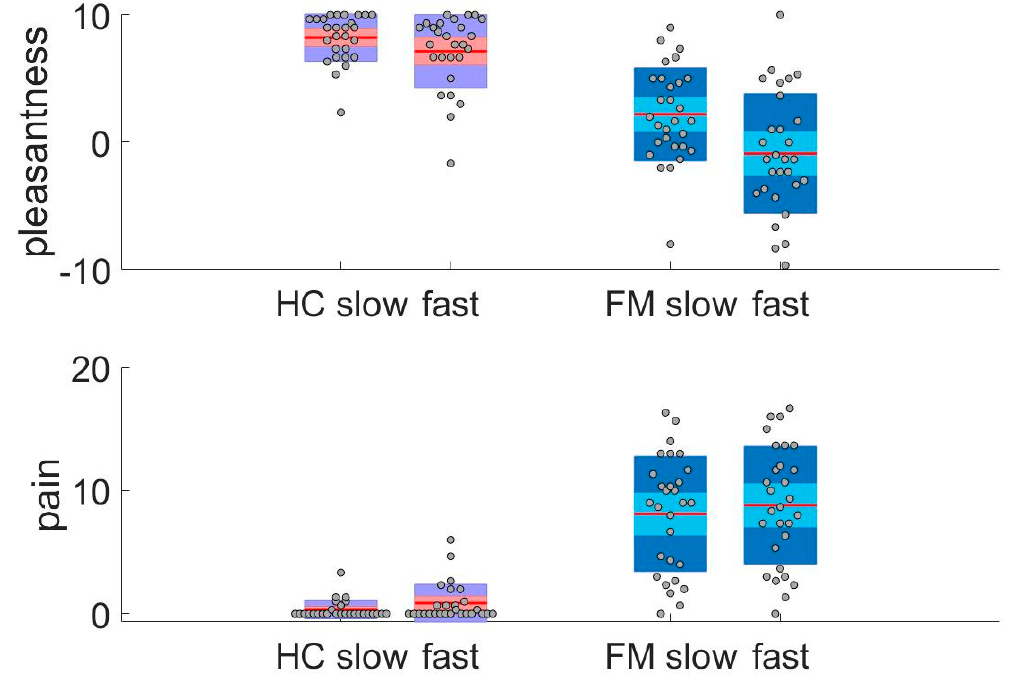
Figure 1. Ratings of touch pleasantness and pain during fMRI. Top: HC rated slow and fast brushing as similarly pleasant on a VAS (mean slow = 8.2 ± 1.9, mean fast = 7.2 ± 3, Z = –1.6, p < 0.103). FM rated slow brushing as significantly more pleasant than fast (mean slow = 2.1 ± 3.7, mean fast = –0.9 ± 4.7, t = 4.9, p < 0.001). Groups di ff ered in their ratings of the di ff erent conditions (Mann–Whitney U test, pleasantness ratings: slow Z = –5.7, p < 0.001, fast Z = –5.4, p < 0.001). Bottom: HC rated less pain after slow than after fast brushing on a VAS (mean slow = 0.33 ± 0.04, mean fast = 0.86 ± 1.53, Z = –2.4, p < 0.017). FM rated less pain after slow than after fast brushing (mean slow = 8.3 ± 4.7, mean fast = 9 ± 4.9, t = –2.7, p < 0.011). The groups di ff ered in their ratings of the di ff erent conditions (Mann–Whitney U test, pain ratings: slow Z = –6.2, p < 0.001, fast Z = –5.9, p < 0.001). Note that the pain ratings were